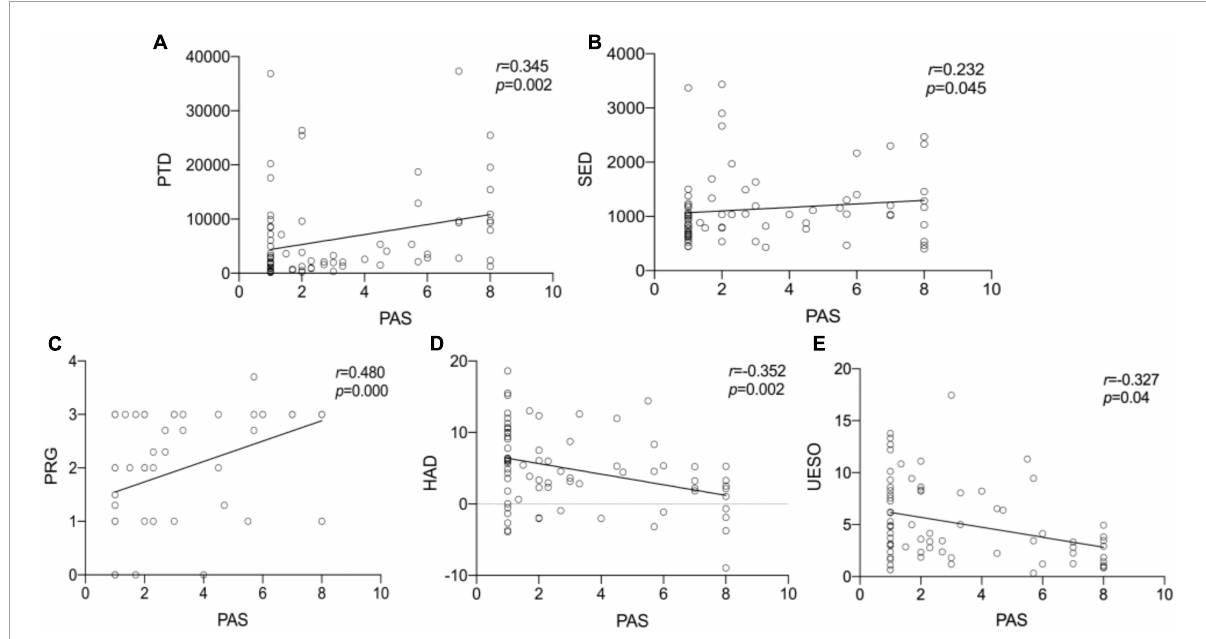
FIGURE7 The Spearman correlation analysis for PTD, SED, PRG, HAD, UESO, and PAS. The correlation between PTD and PAS (A) . The correlation between SED and PAS (B) . The correlation between PRG and PAS (C) . The correlation between HAD and PAS (D) . The correlation between UESO and PAS (E) . There was a significant correlation between PAS and PTD, PRG, HAD, UESO, among which PRO exhibited moderate correlation. PAS, Penetration-Aspiration Scale; PRG, Pharyngeal Residual Grade; PTD, pharyngeal transit duration; HAD, hyoid bone anterior-horizontal displacement; SED, soft palate elevation duration; UESO, upper esophageal sphincter opening.